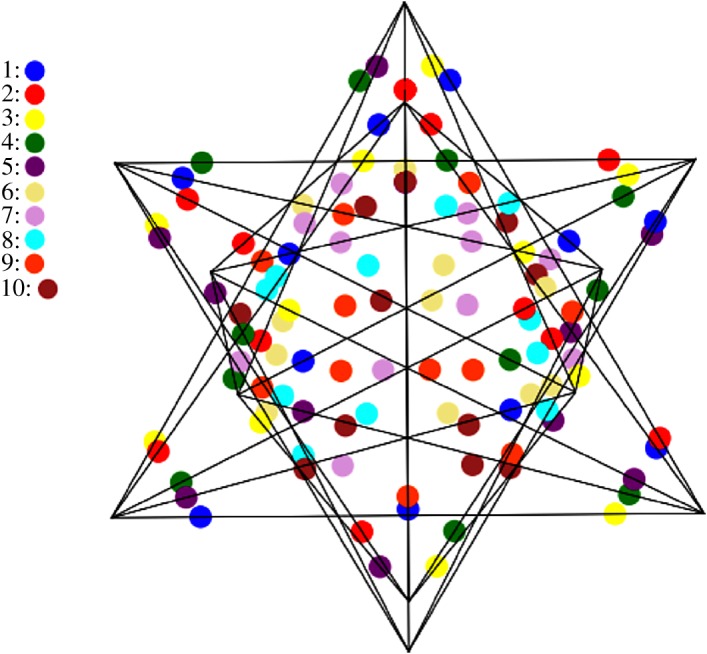
A colouring with 10 colours, see a corresponding schedule in figure 14.